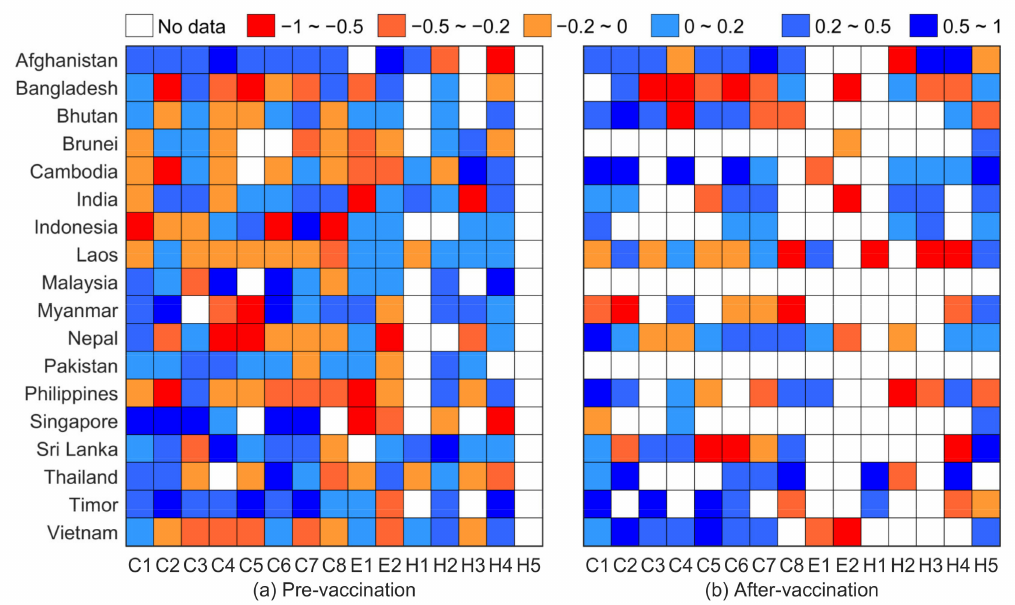
Figure 2. Response intensity of intervention measures to daily new cases before and after vaccine availability (response intensity is based on a correlation analysis; a stronger response corresponds to a larger negative value). Closures and containment measures including school closures (C1), workplace closures (C2), public event cancellations (C3), restrictions on gatherings (C4), public transport closures (C5), stay at home requirements (C6), restrictions on internal movement (C7), and restrictions on international travel (C8). Economic measures included income support (E1) and debt/contract relief for households (E2). Public health measures include public information campaigns (H1), testing policies (H2), contact tracing (H3), face coverings (H4), and vaccination policies